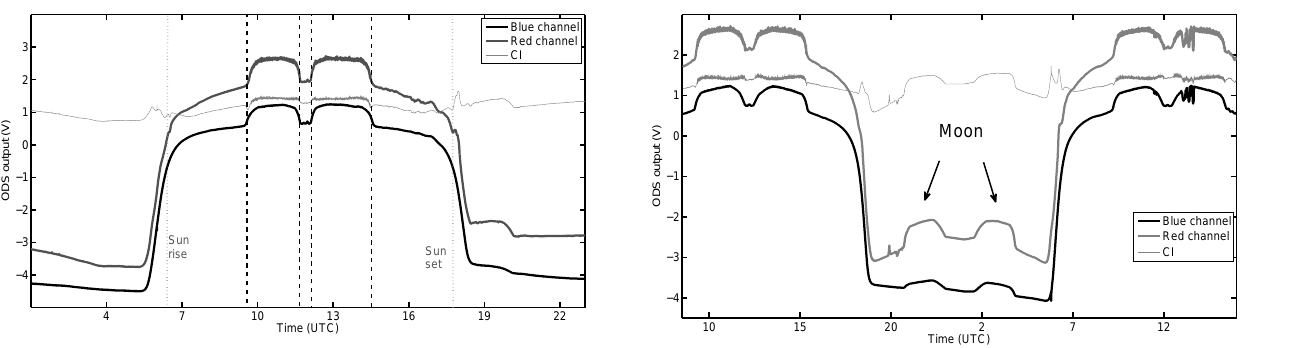
Figure 6. Moonlight ODS measurements in Ouagadougou on 23– 24 February 2005.